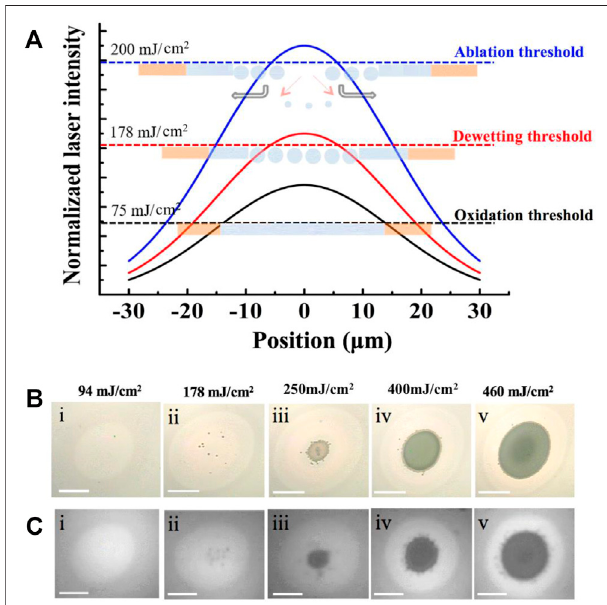
FIGURE 5 | Energy-dependent oxidation, dewetting, and ablation states. (A) Normalized laser intensities of the oxidation, dewetting, and ablationthresholdontheCuthin fi lmwithcorrespondingintroducedoxidation, dewetting, and ablation sizes. Absorbed laser intensities are normalized by the peak intensities of the blue curve. (B) Ex-situ optical bright- fi eld microscopyimagesoftheprocessedmorphologywithdifferentlaser fl uences. (C) In-situ time-resolved re fl ection images of morphologies with corresponding fl uences captured at 40 ns after irradiation (The scale bars are 20 μ